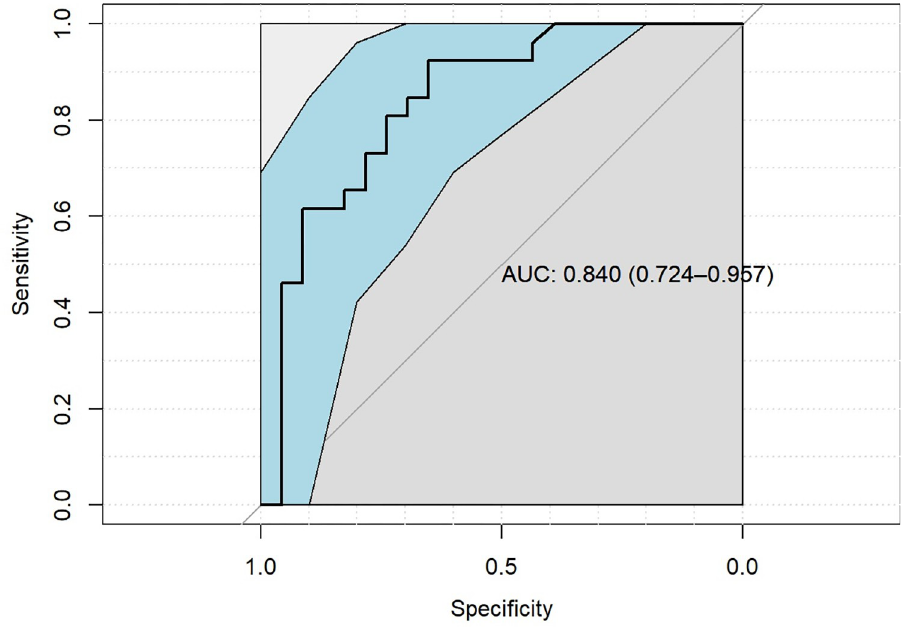
Fig 2. ROC curve peak lactate level.